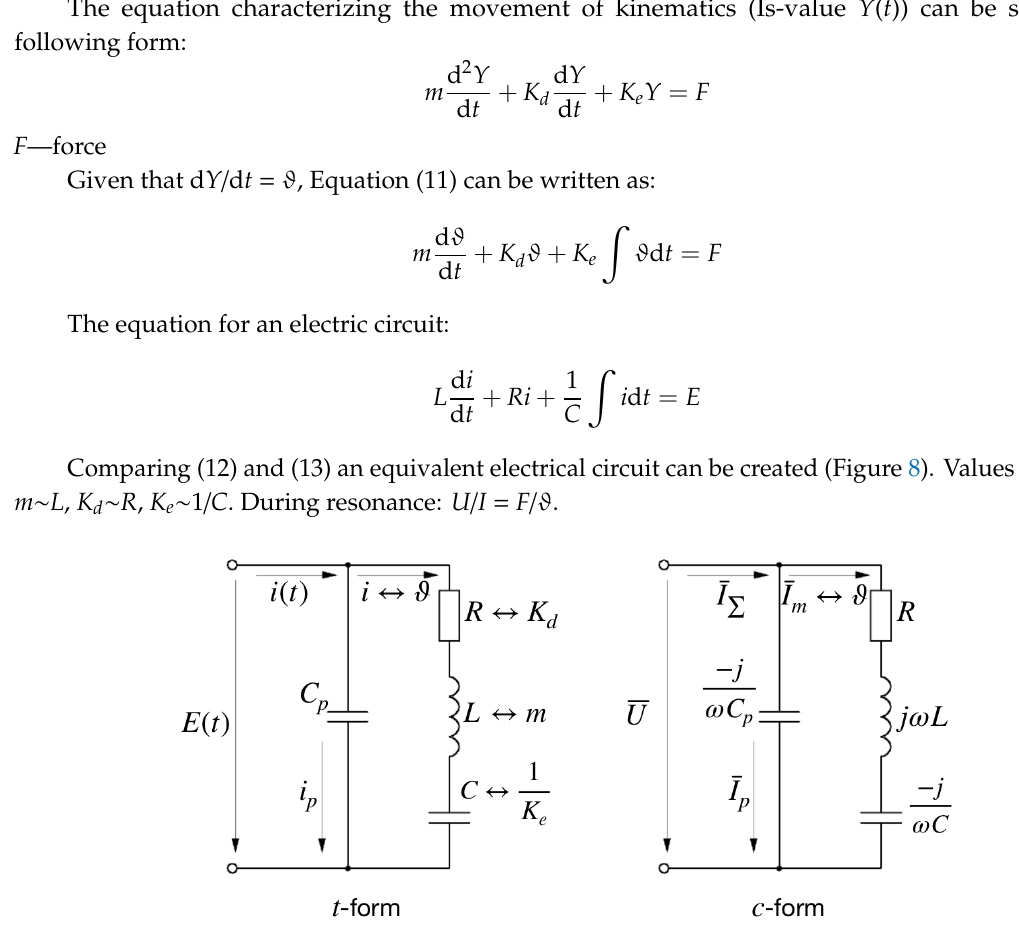
Figure 8. Piezoelectric actuator equivalent circuit.